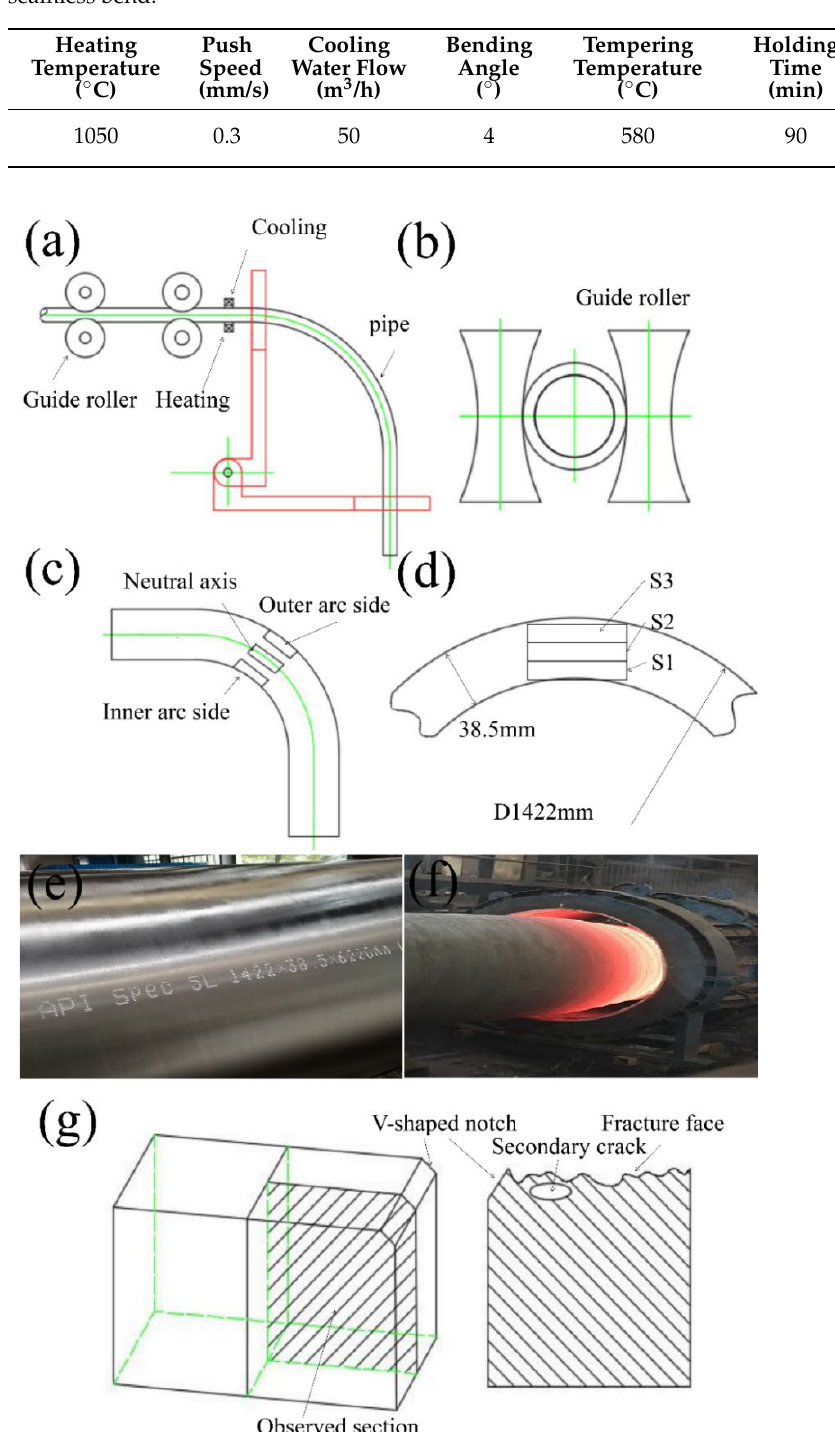
Figure 1. Heat-induced bending process and sample location: ( a – c ) the schematic diagram of the heat-induced bending process, ( d ) the location of the test sample, ( e ) the parent pipe of the bend, ( f ) the production site diagram of industrial induction heating bending, and ( g ) the schematic diagram of secondary crack observation.